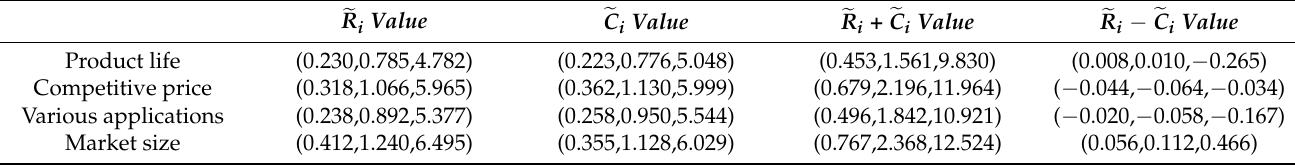
Table 3. The sum (cid:101) R i value , (cid:101) C i value , (cid:101) R i + (cid:101) C i value and (cid:101) R i − (cid:101) C i value impacts of the second-level criteria of the market